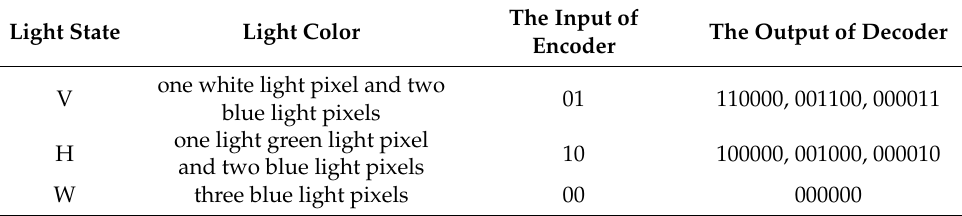
Table 2. Correspondence of the light state, light color, and input and output data. Light State